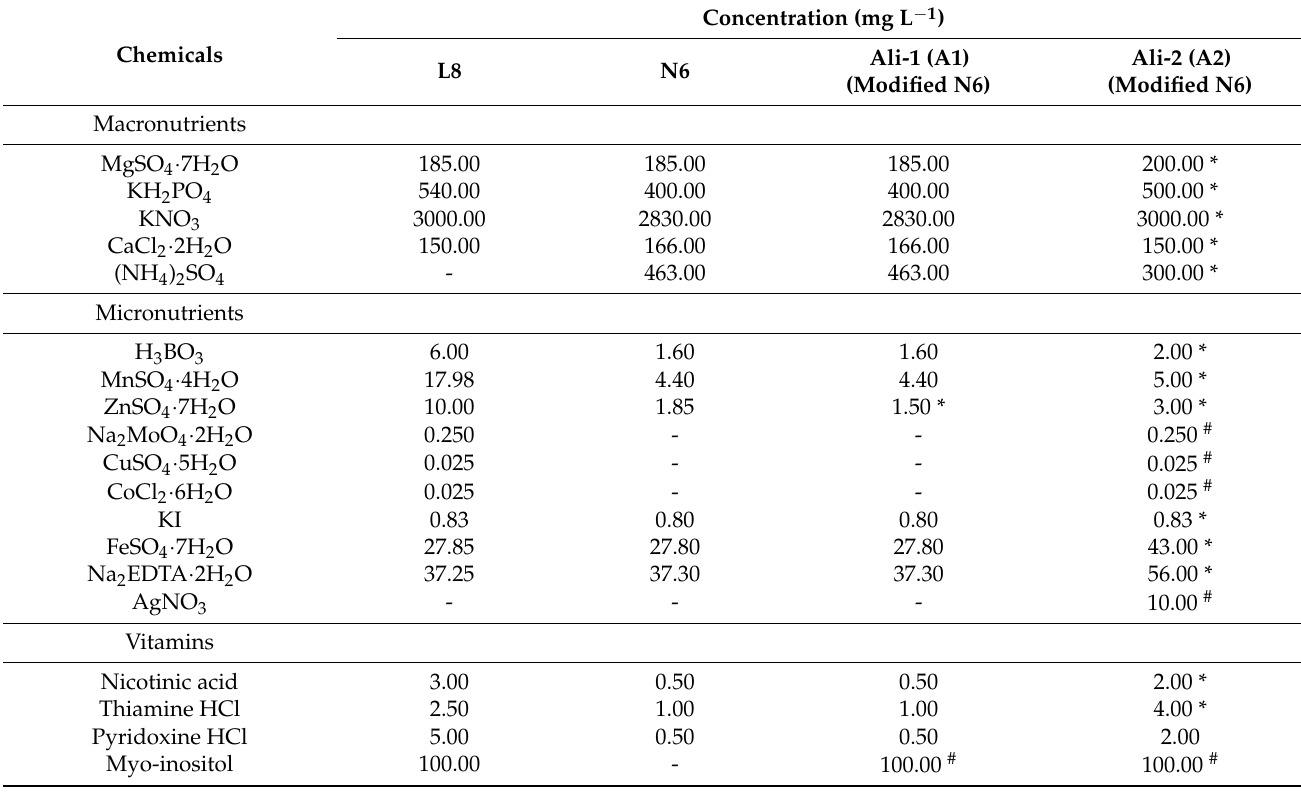
Table 1. Nutrient composition of four callus induction media used for the